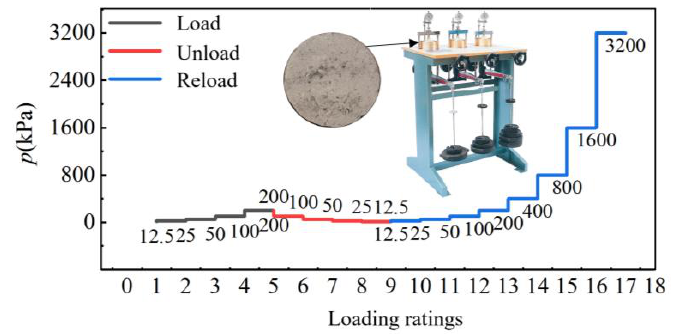
Figure 4. The apparatus and loading ratings of the oedometer test.